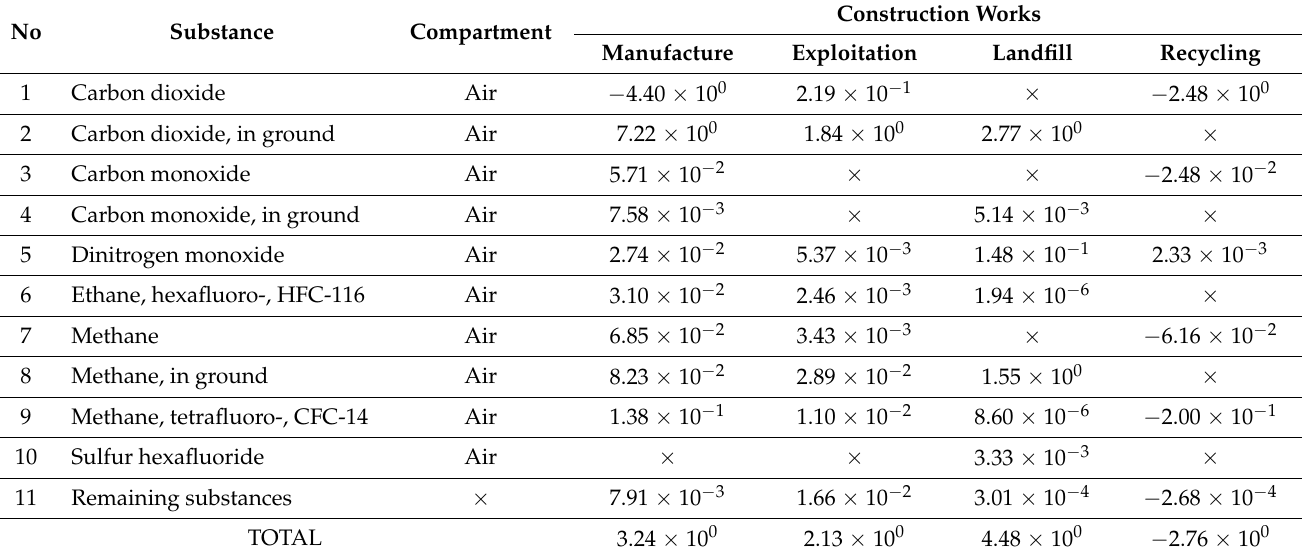
Table 12. The results of grouping and weighing the environmental consequences of emissions of compounds causing climate change due to construction works occurring at individual stages of the life cycle of the research object.